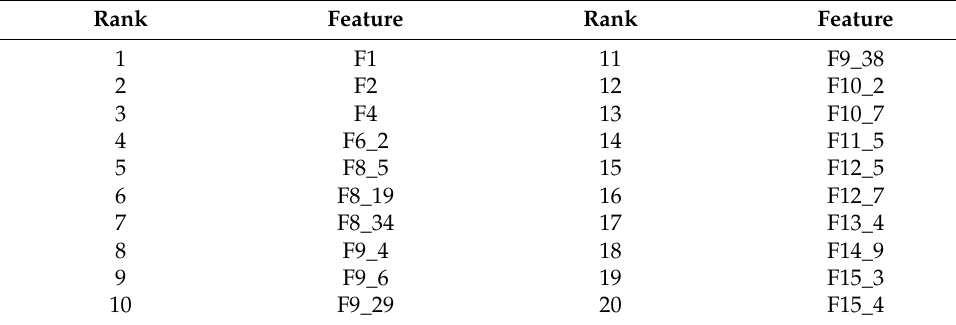
Table 4. Important features selected by